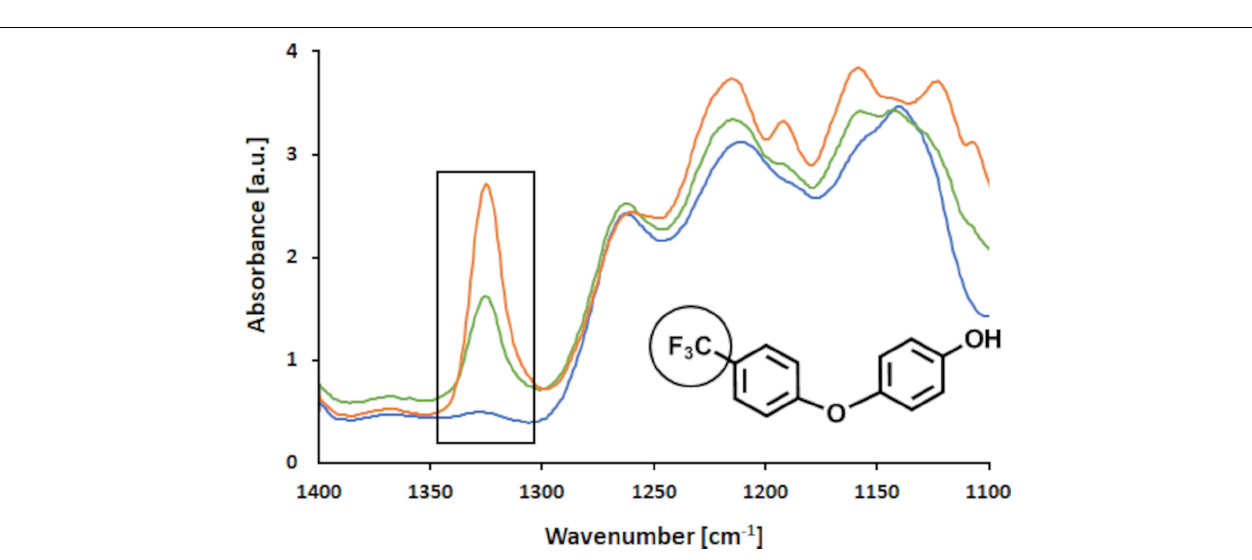
FIGURE 8 | Swelling results for the laccase catalyzed coupling of FP onto LS. All reactions were conducted at pH 7. The control reaction was carried out at 23 ◦ C without FP added.